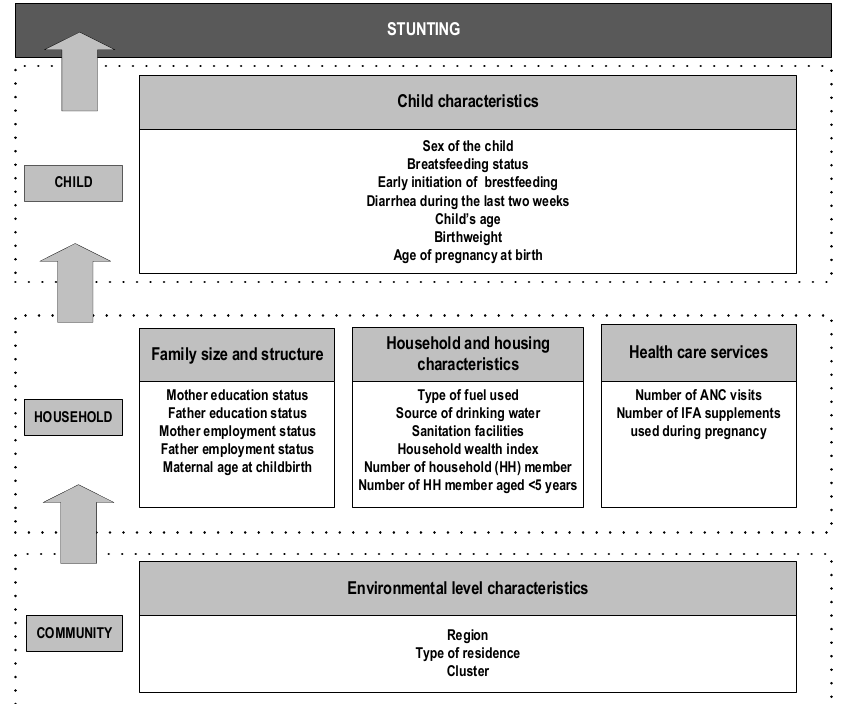
Figure 1. An analytical framework for factors associated with stunting among children under two years of age in Indonesia.